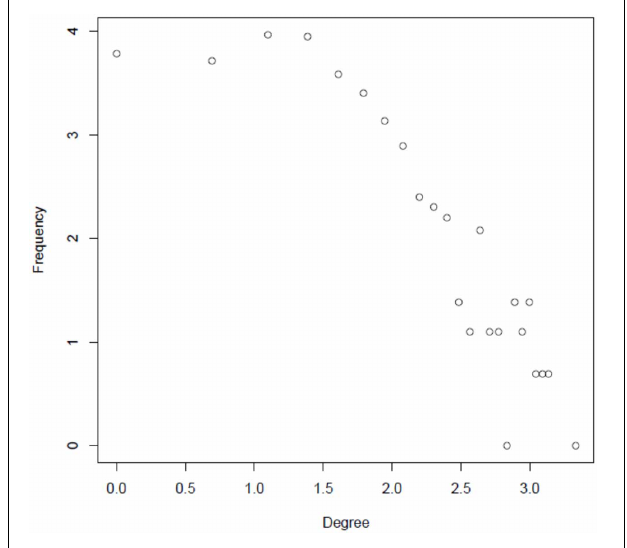
FIGURE 4 | Degree distribution of the reconstructed integrated network in a log–log plot (natural